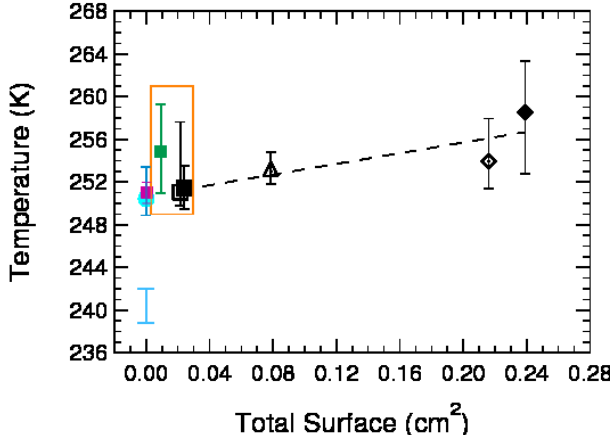
Fig. 4. Bulk freezing temperatures as a function of the surface area of Ey0 ash in the sample. The dashed line shows a linear fit of T f to the surface area of ash in sample. Pure water is not included in the fit. The black symbols represent the different ash samples: Open square – Ey0 0.2wt% < 20µm; Filled square – Ey0 0.5wt%; Open triangle – Ey0 0.05wt% < 1µm; Open diamond – Ey0 2wt% < 20µm; Filled diamond – Ey0 5wt%g. The light blue circle shows the freezing temperature of pure water, bulk sample; Light blue error bar 239–242K – homogeneous freezing temper- ature of bulk water sample, calculated using the nucleation rates of Zobrist et al. (2007) and Earle et al. (2010), respectively; The other coloured symbols represent values from the literature: Purple square – Shaw et al. (2005); Green square – Fornea et al. (2009); Area marked by orange rectangle – Durant et al. (2008); The size of the error bars is given by the range of the freezing temperatures for a particular surface area of ash, and not by the precision of the